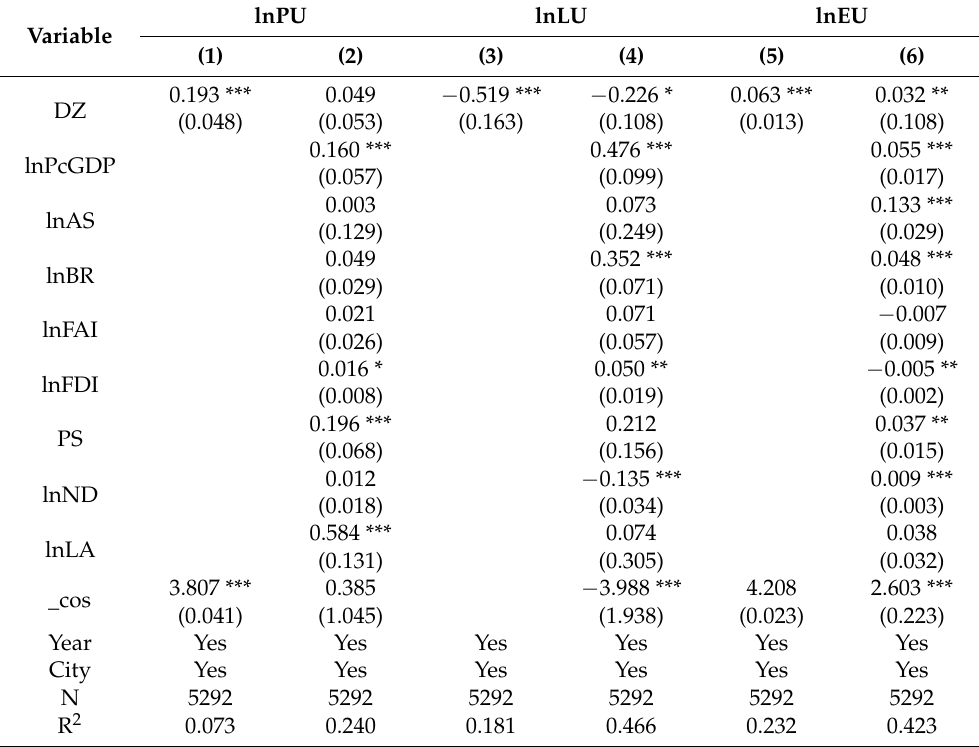
Table 4. Basic regression of the impact of DZs on